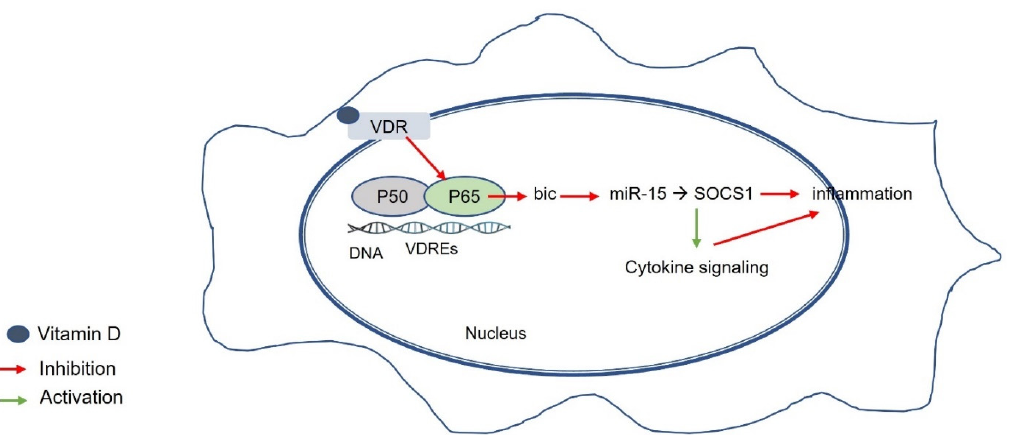
Figure 4. Vitamin D–VDR-mediated effects on primary biliary cholangitis (PBC). Vitamin D–VDR signaling alleviates inflammation by targeting the miRNA155-SOCS1 axis in PBC. VDR/miRNA155- modulated SOCS1 expression is reduced in PBC, resulting in impaired regulation of cytokine signaling. VDR, vitamin D receptor; VDRE, vitamin D response element; miR155, microRNA 155; SOCS1, suppressor of cytokine signaling 1.